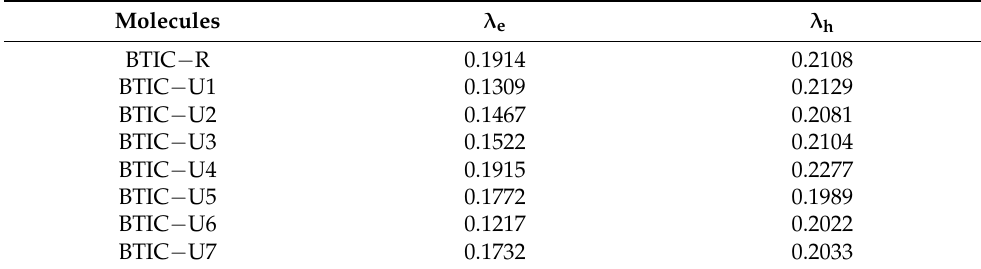
Table 7. RE of λ e and λ h for BTIC-R and BTIC-U1 to BTIC-U7 molecule.